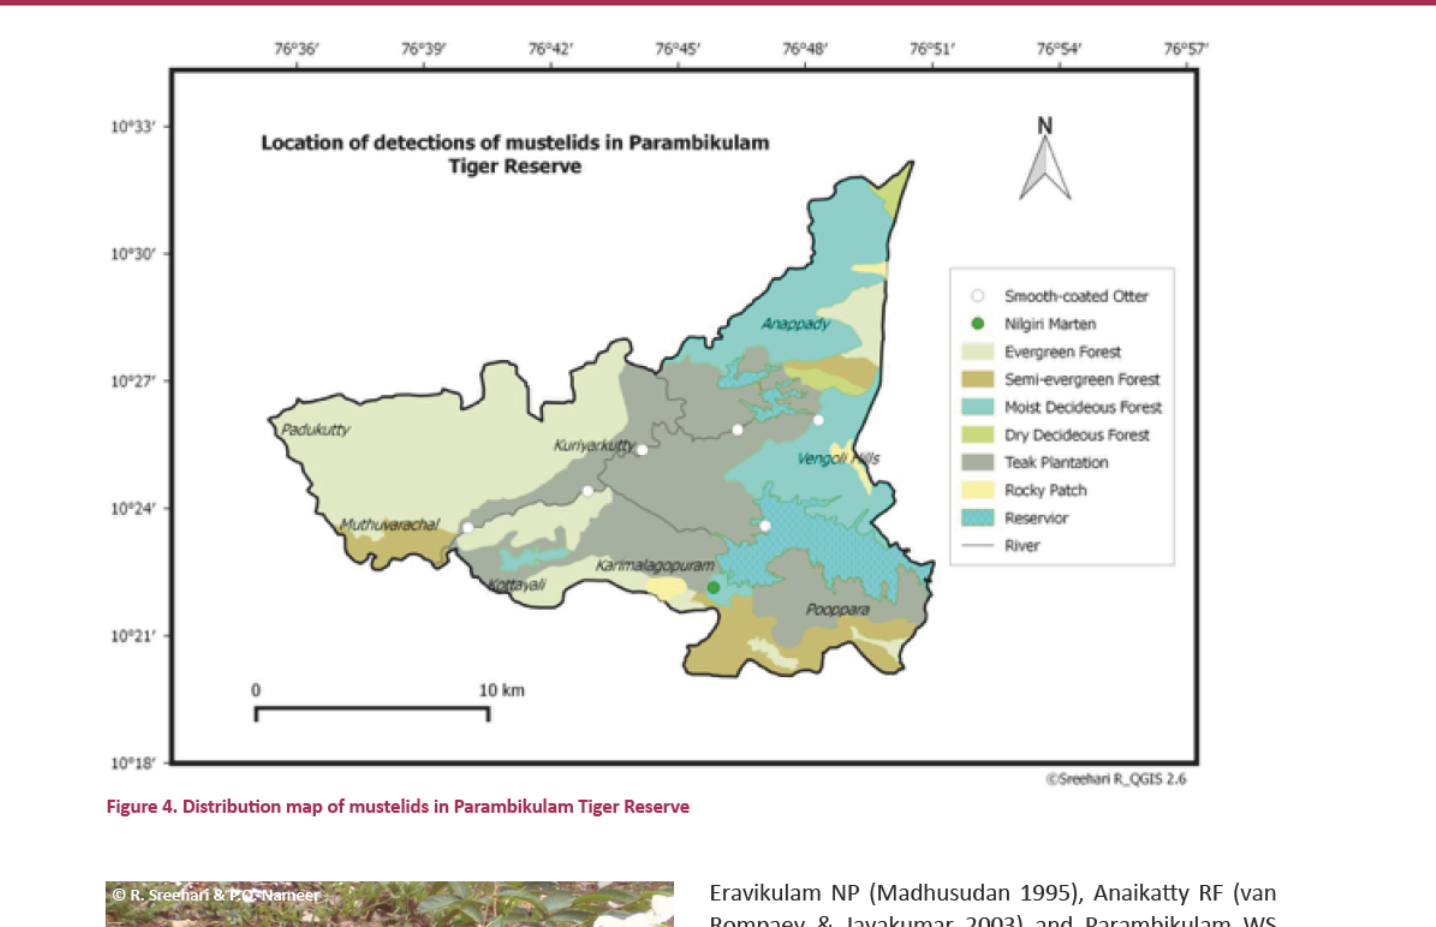
© R. Sreeharfi & P.O.